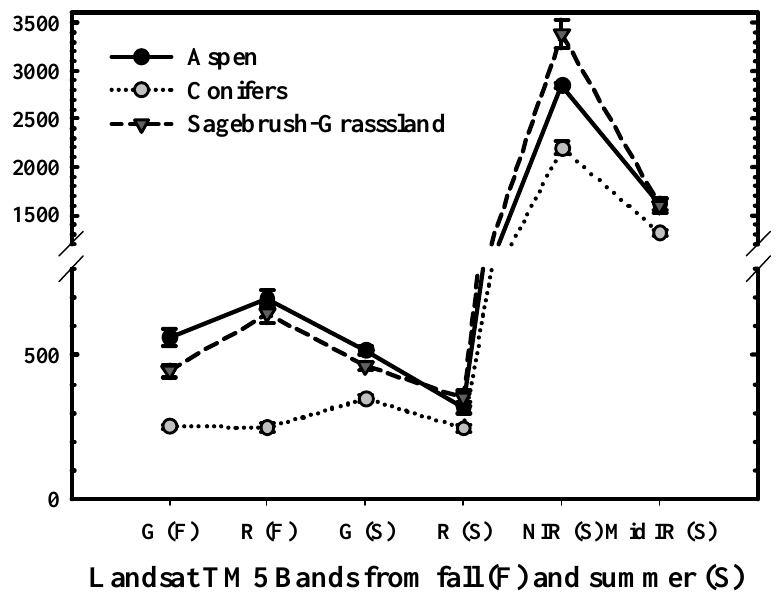
Figure 2. Mean spectral reflectance of aspen and other dominant vegetation cover types within the study area in green (G = 0.52–0.60 μ m), red (R = 0.63–0.69 μ m), near infrared (NIR = 0.76–0.90 μ m), and middle infrared (Mid IR = 1.55–1.75 μ m) portions of the electromagnetic spectrum in the fall (F) and summer (S) seasons. Error bars are standard